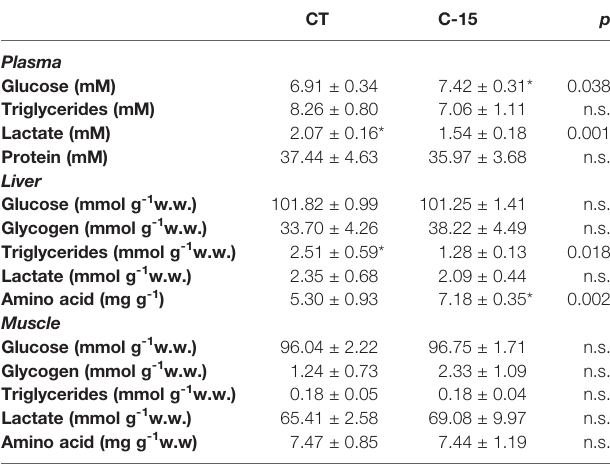
TABLE 9 | Tissue metabolites content of juvenile C. labrosus fed control (CT) and C-15 diets during 90 days. CT C-15